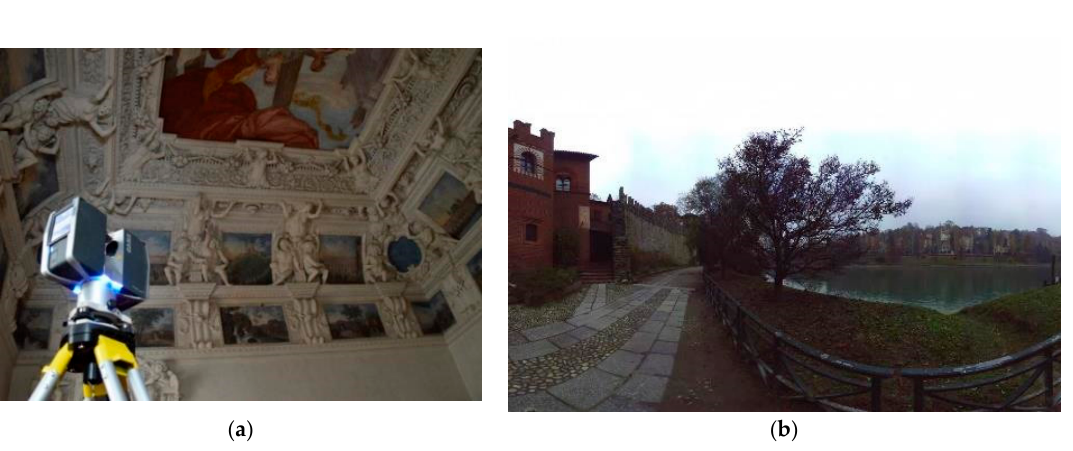
Figure 3. Terrestrial Laser Scanner (TLS) by FARO ® : ( a ) The FARO ® Focus 120 during the acquisition and ( b ) planimetric view of an outdoor coverage range of an X330 scanner.